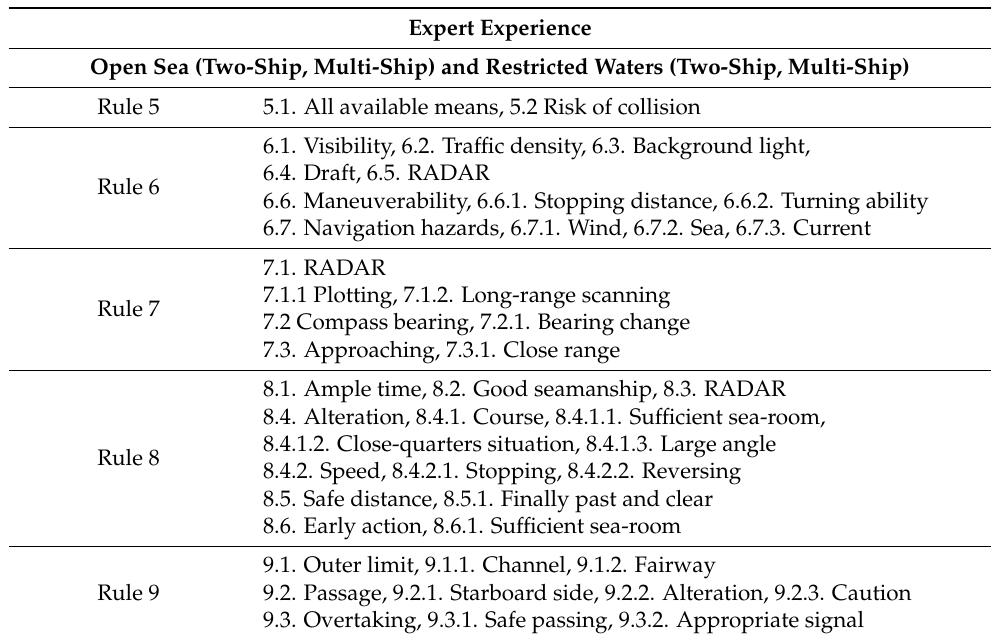
Table 7. Requirements analysis for expert